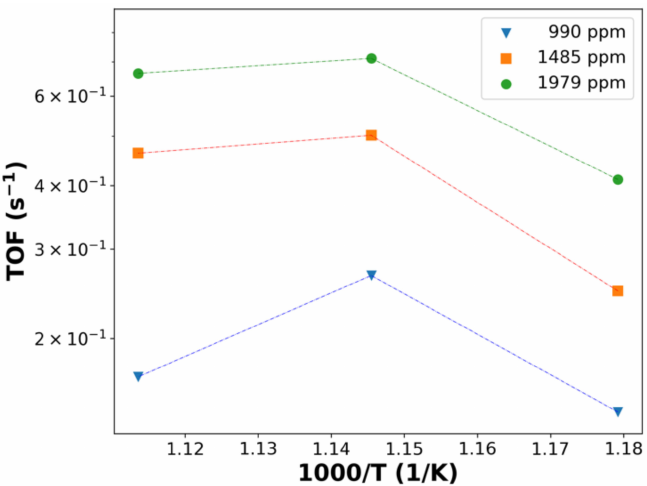
Figure 4. Arrhenius plot for toluene decomposition. Temperature values were 575 ◦ C, 600 ◦ C, and 625 ◦ C. The space velocity was 700 mL/(min · g cat ). Catalyst mass of 0.1 g. Note that the y - axis is logarithmic. For TOF calculation the metal exposed surface was as follows: Fe/CAG had 0.03894 mmol Fe/g of the catalyst; Fe/CAG-ps had 0.03789 mmol Fe s /g of the